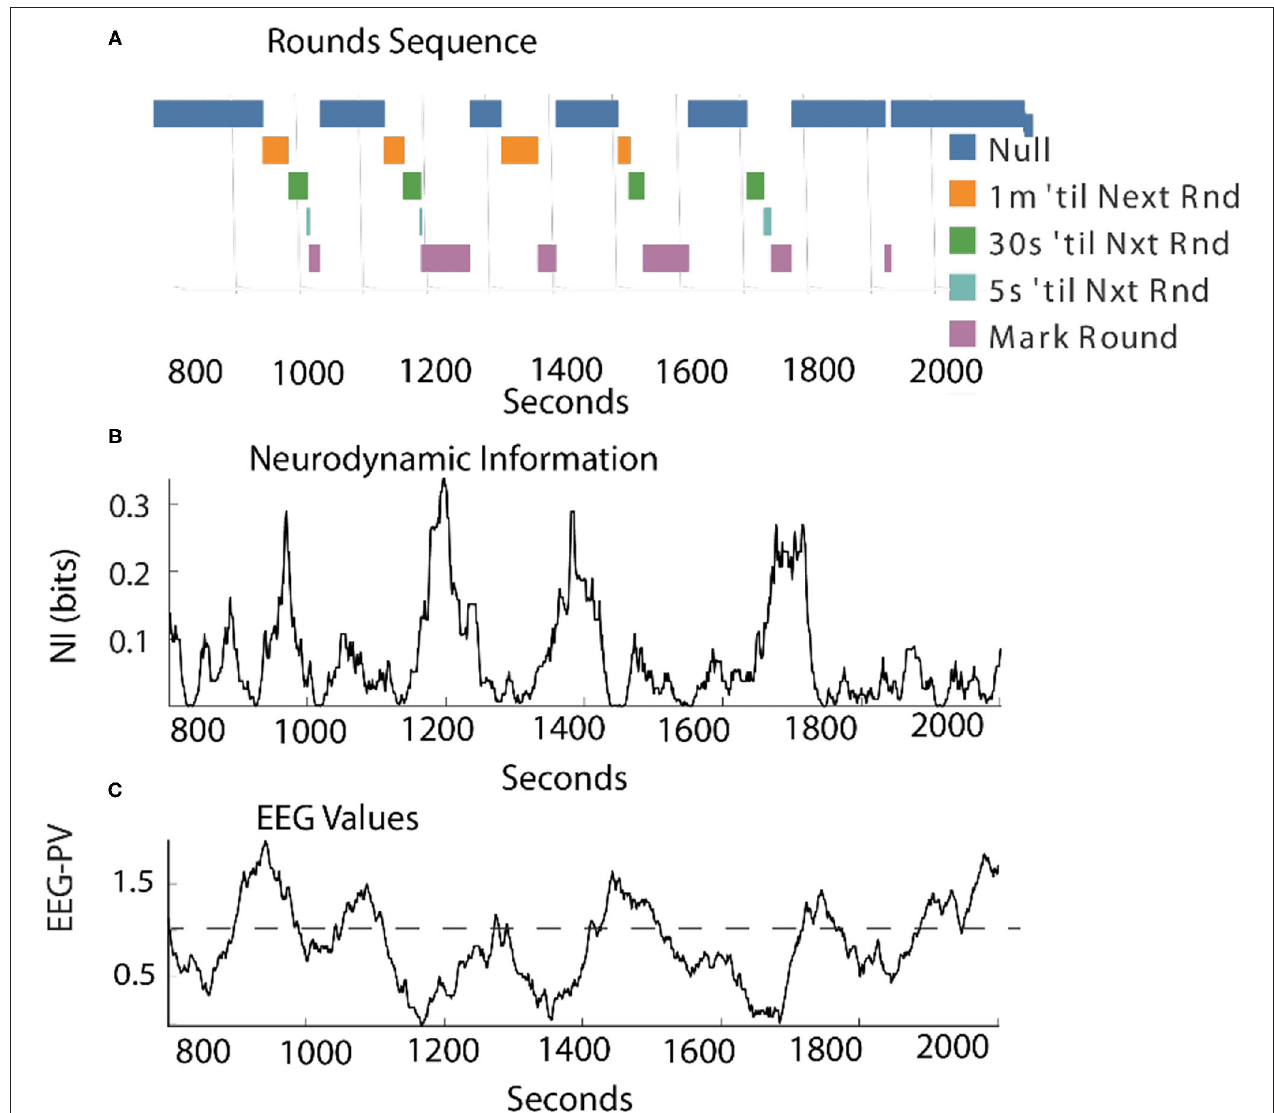
FIGURE 7 | Comparison of the NI and EEG-PV dynamics of the Contact Manager. (A) The countdowns for the last minute of the five Rounds sequences are plotted vs. time. These figures plot the NI (B) and the EEG-PV (C) for the CM. The dotted line in (C) shows the 11Hz frequency of 1.0 that demarcates positive and negative values. All values are from the FzP0 dipole of each person. The average value of the randomized NI was 0.01 bits. The correlation between (B) and (C) was r =